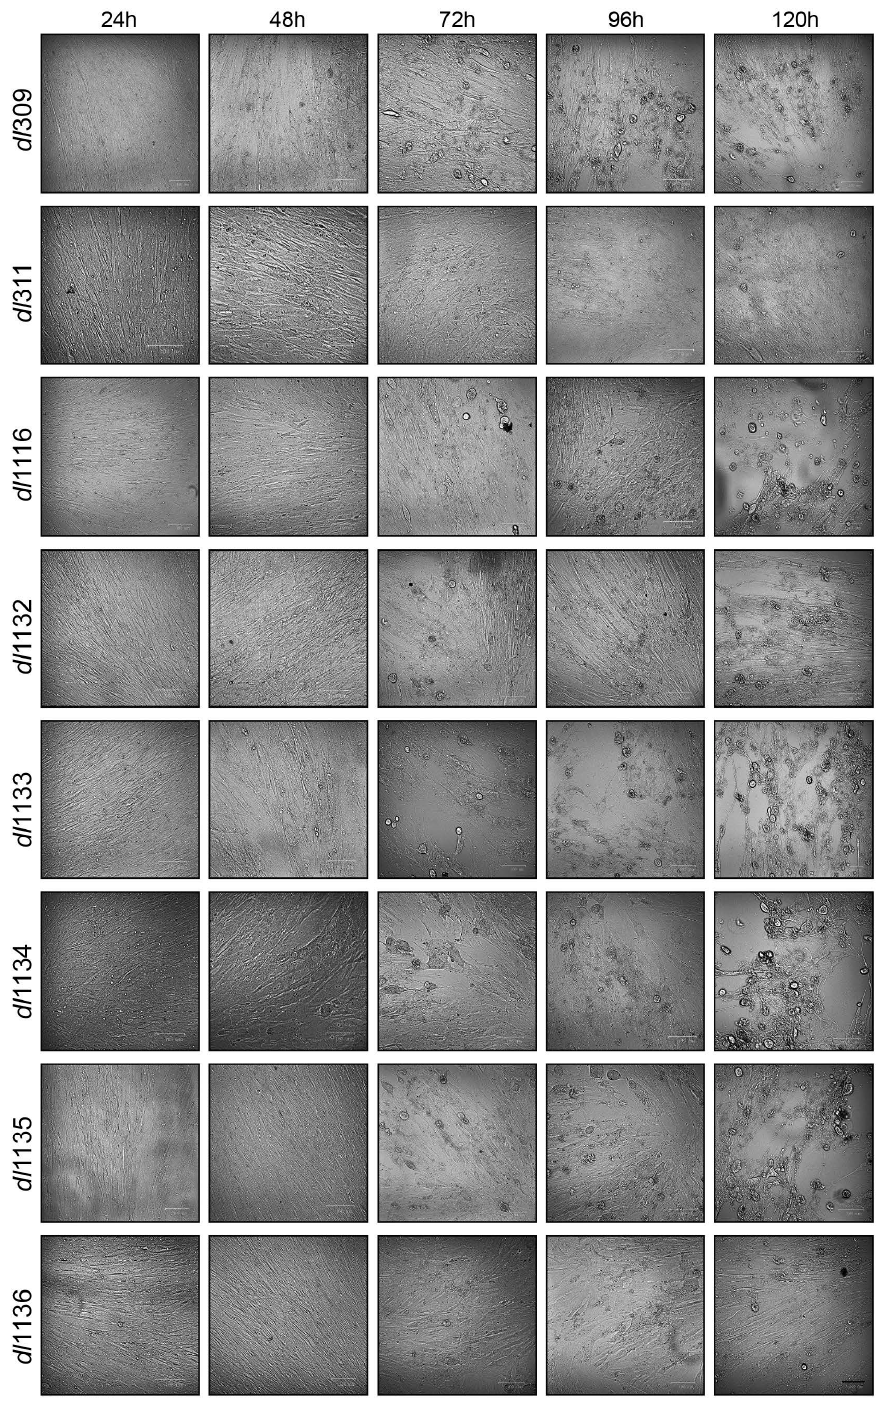
Figure 2. Deletions within the E1A C-terminus affect appearance of CPE. Arrested WI-38 cells were infected at a MOI of 100 and imaged at the indicated time points. Bar in lower right corner represents 100 μ m, cells were all imaged using the same magnification (20× objective lens).